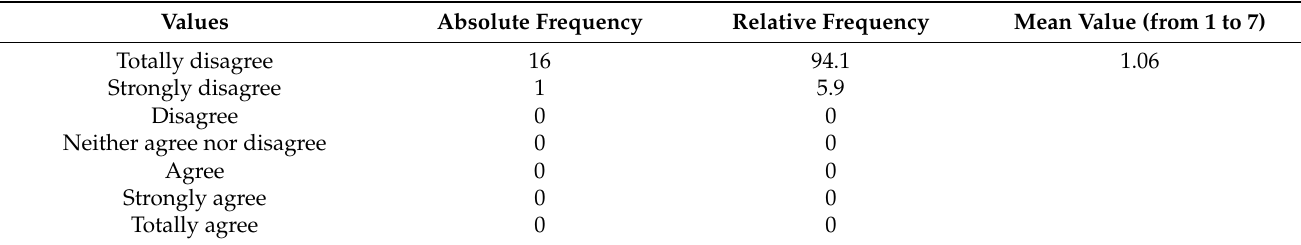
Table 5. Analysis of the results for item 5: “Women are not as skilled as men in managing areas,